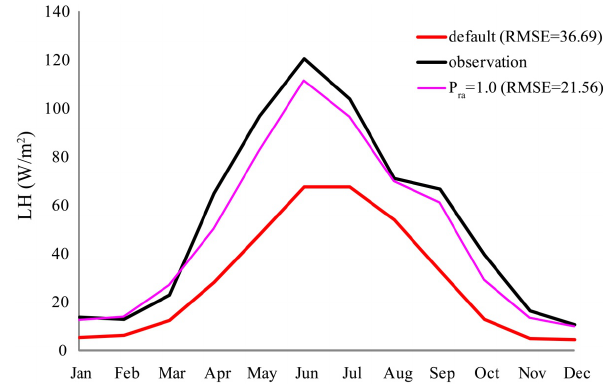
823 Figure 10. Simulated heat fluxes using the posterior estimates of parameters at the US-MOz site. 824 Fig. 10. Simulated heat fluxes using the posterior estimates of pa- rameters at the US-MOz